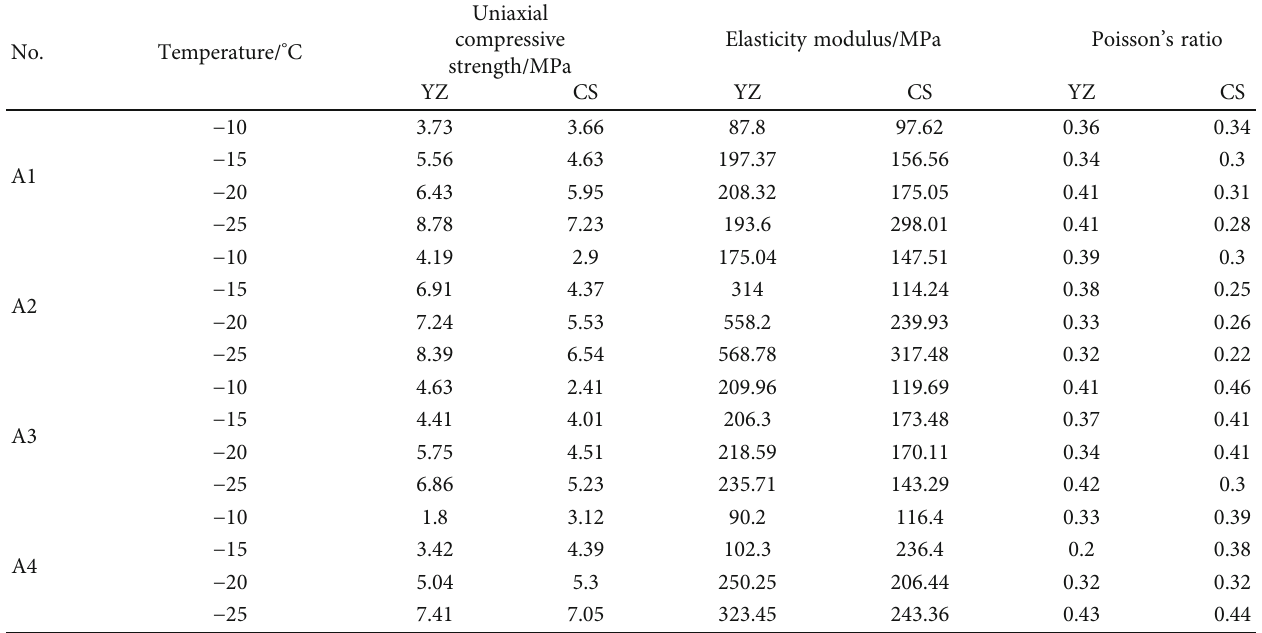
Table 2: Summary data of uniaxial test results of frozen soil.